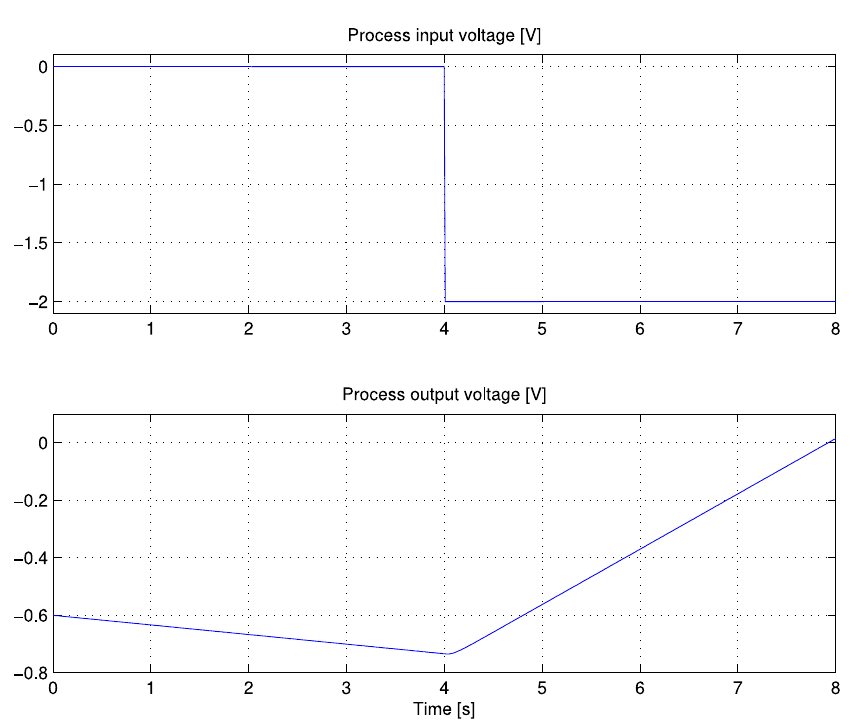
Figure 17. Open-loop response of control system for charge-amplifier drift compensation.